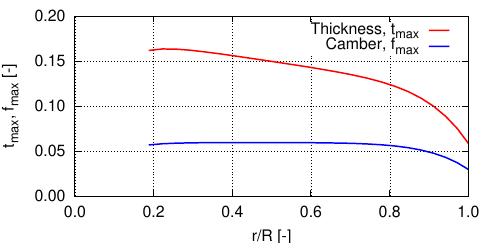
Fig. 8. Model turbine: baseline profile maximum thickness and camber radial distributions (blade root at r/R = 0.2).